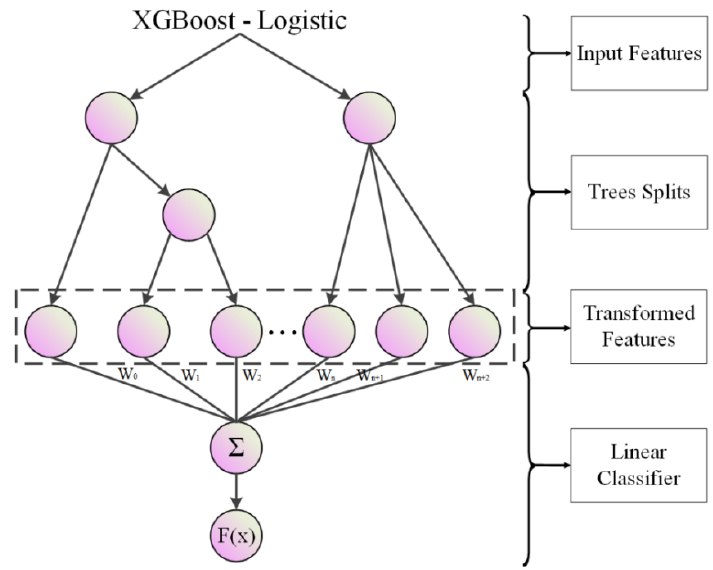
Figure 5. Schematic of XGBoost-logistic combined model construction. The weight of evidence (WoE) is the logarithm of the ratio of normal to defaulted firms under any segmentation in the sample of all firm data